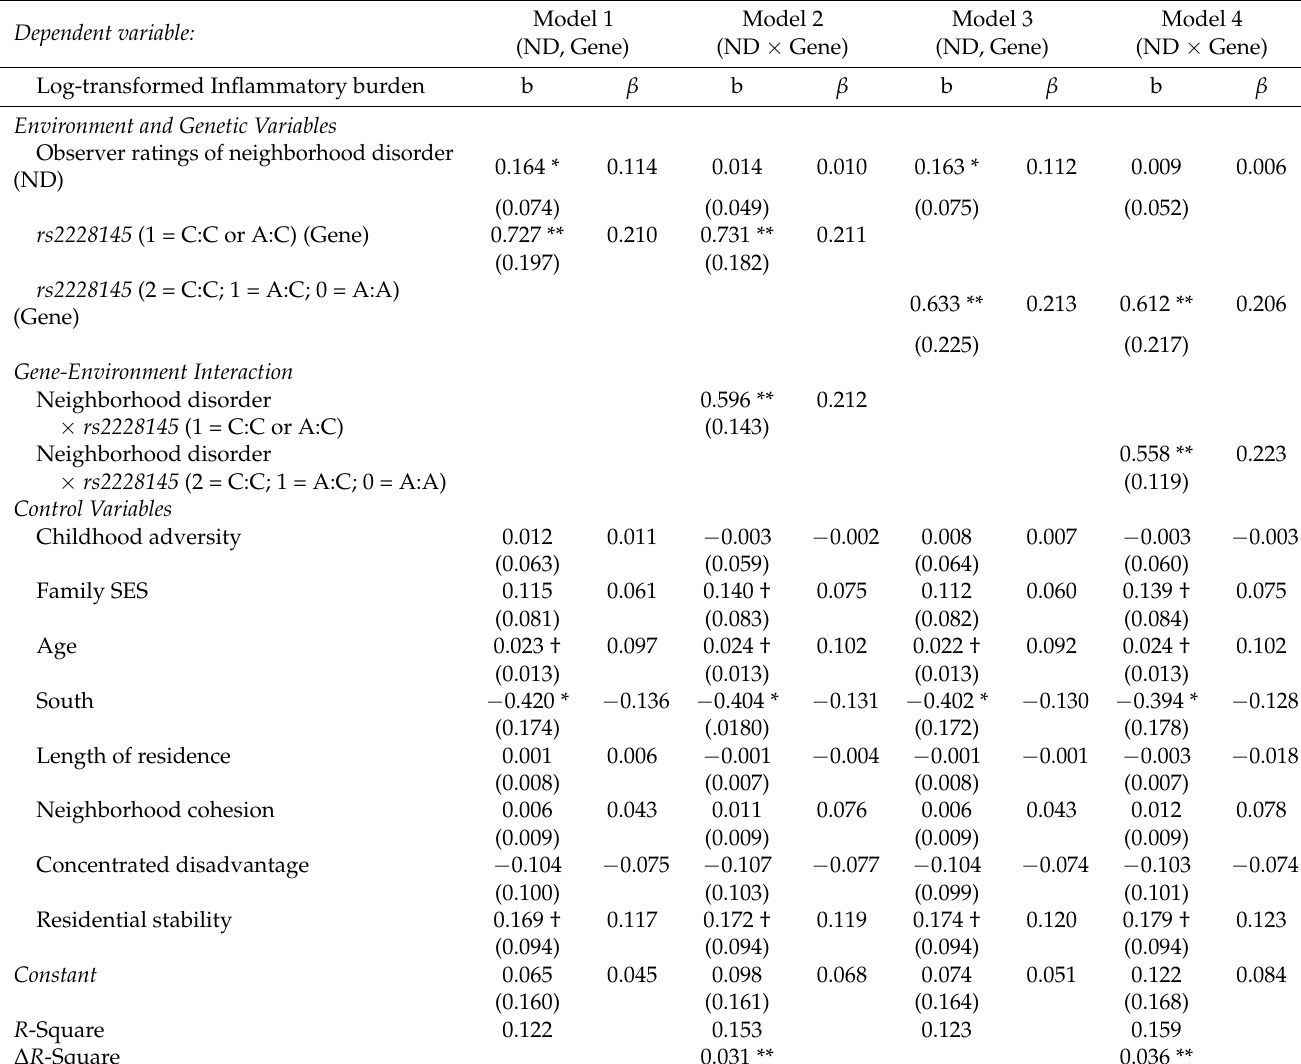
Table 4. Regression of inflammatory burden on observer ratings of neighborhood disorder and